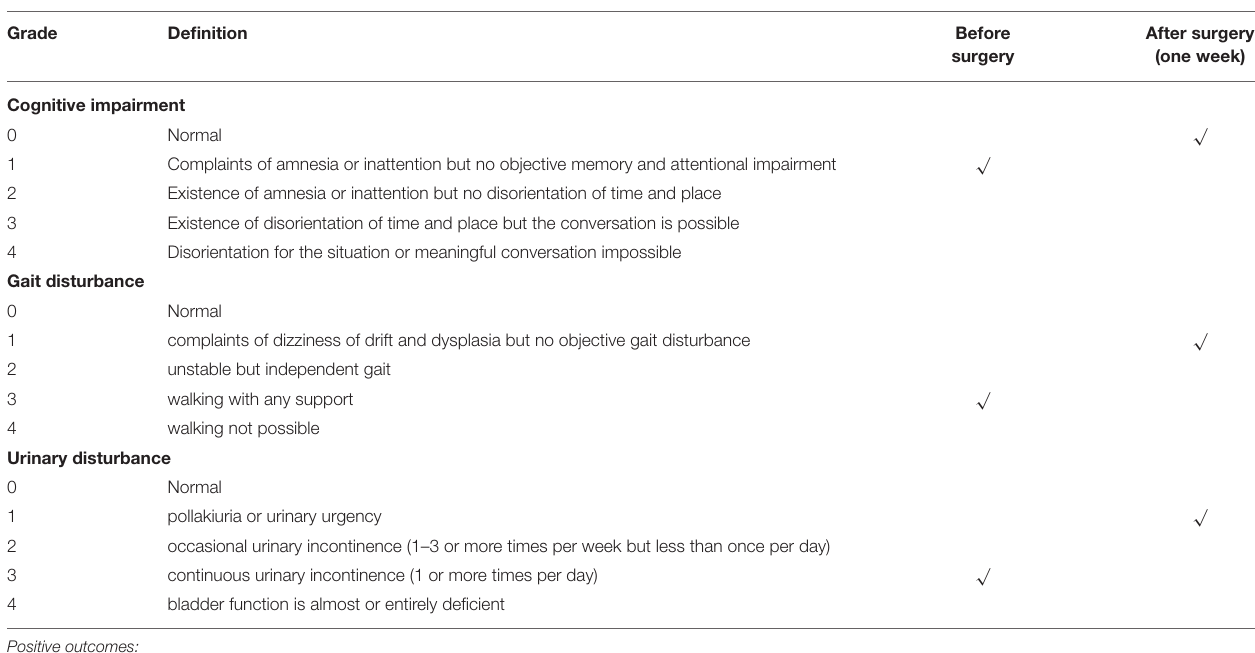
TABLE 1 | iNPH grading scale.